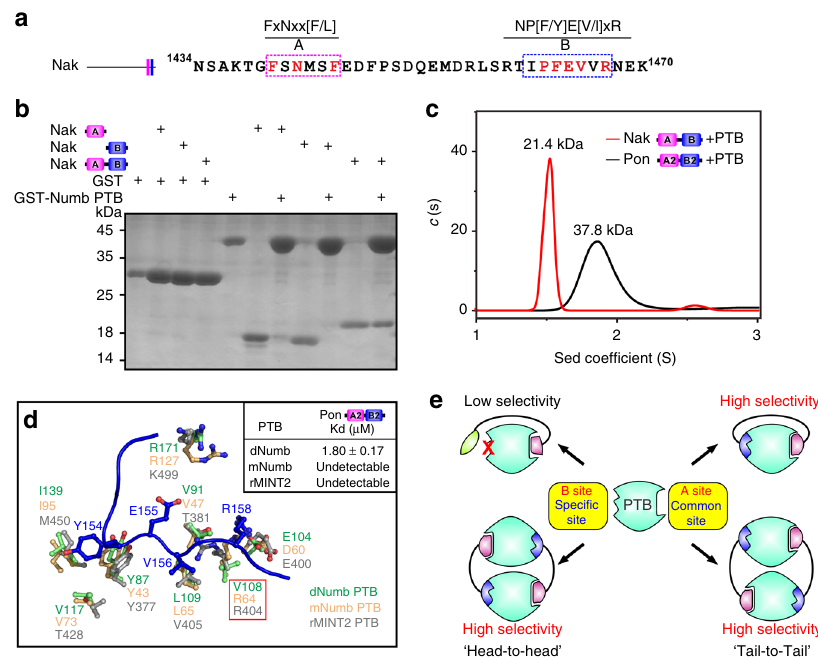
Fig. 3 Ef fi cient combination of A and B motifs enhances the target-binding af fi nity and selectivity of PTB domain. a The C terminus of Nak contains both A and B motifs. b GST pull-down assay showing that combination of both A and B motifs strengthened the interaction between Nak and Numb PTB. The uncropped gel is shown in Supplementary Fig. 10. c Sedimentation velocity (SV) experiments of Numb PTB in the presence of three molar ratios of Nak AB. The SV pro fi le of PTB/Nak AB displays as a major peak corresponding to a 1:1 heterodimer (21.4 kDa, red line). The theoretical molecular weights of PTB and Nak AB are 15.7 and 4.0 kDa, respectively. The SV pro fi le of Numb PTB/Pon A2B2 is also shown for the reference (black line). d Superimposition of Drosophila Numb PTB/Pon A2B2 complex (green) with mouse Numb PTB (orange, PDB ID: 1WJ1) and rat MINT2 PTB (gray, PDB ID: 3SV1). Pon A2B2 selectively binds to Drosophila Numb PTB, but not mouse Numb PTB or rat MINT2 PTB. The key residues involved in Pon B2 binding are shown in the ball-and-stick model. e A model depicting potent and speci fi c PTB-target